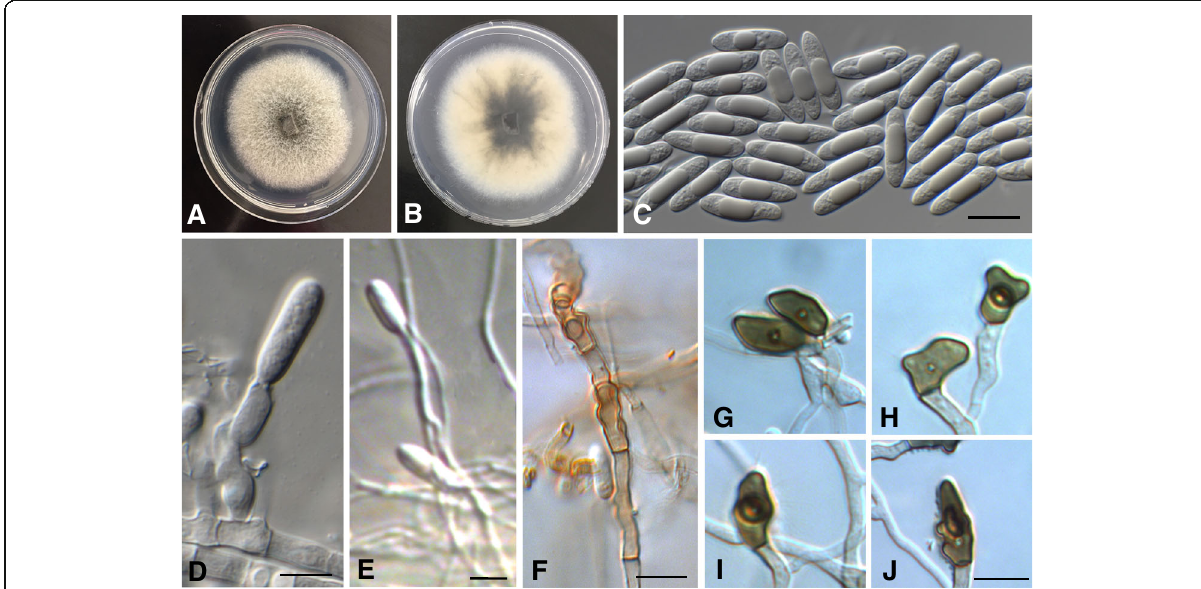
Fig. 8 Colletotrichum tainanense (CBS 143666). a Colony on PDA. b Reverse side of the colony on PDA. c Conidia. d-e Conidiophores and Conidia. f Melanised hypae g-j Appressoria. Bars = 10 μ